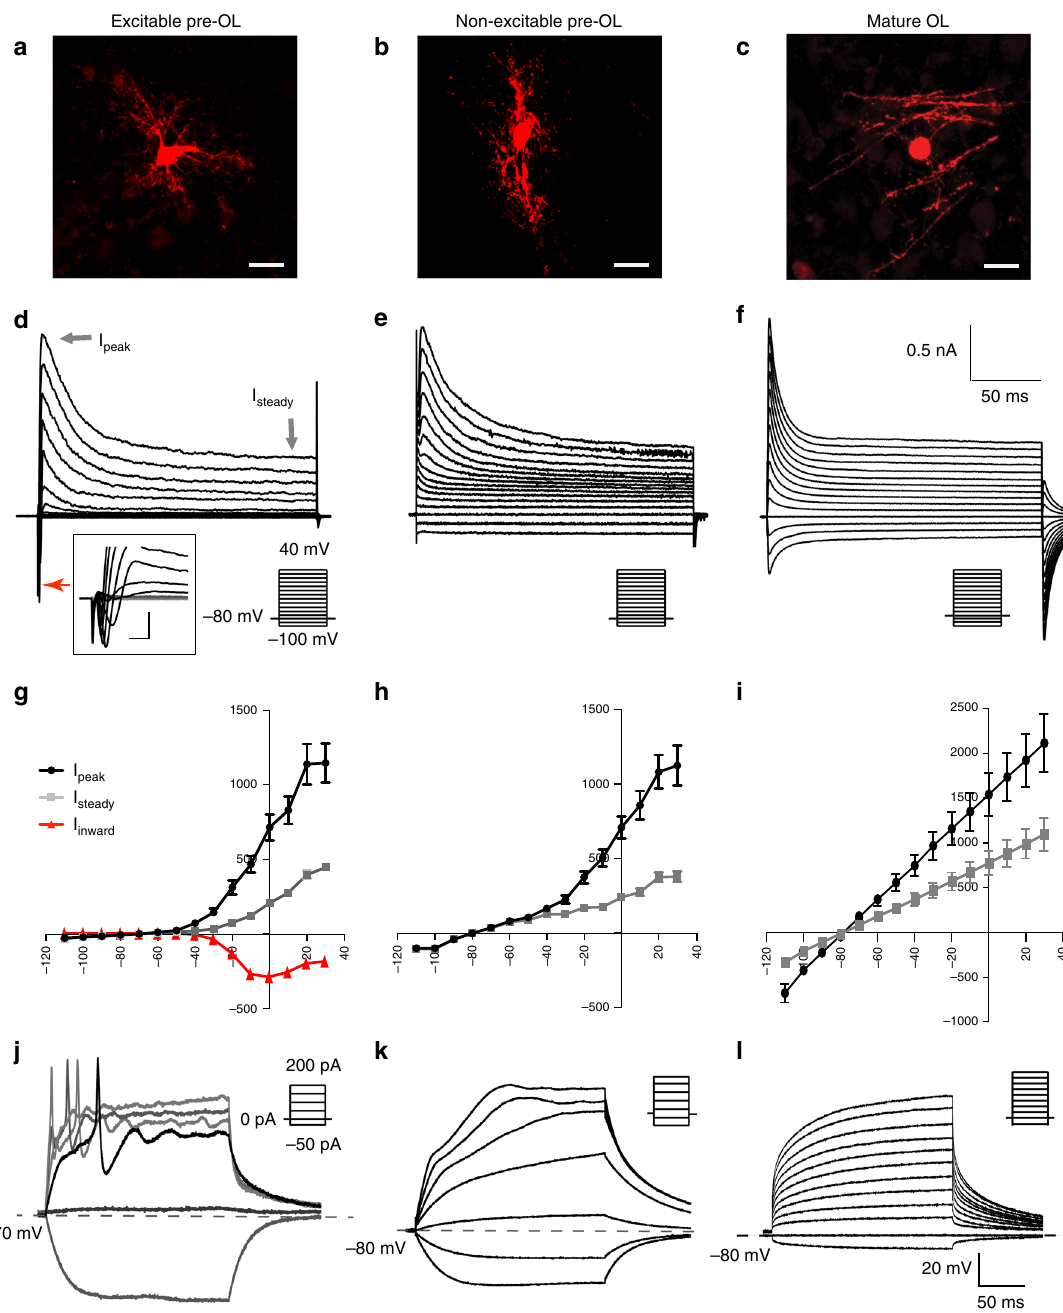
Fig. 3 Morphology and physiological properties of excitable vs. non-excitable pre-OLs and mature OLs. a – c Confocal images of excitable pre-OLs a , non-excitable pre-OLs b , and mature OLs c , which were fi lled with Alexa 568 during whole-cell recordings. Scale bar , 10 μ m. d – f Representative traces of Na v -mediated currents generated by voltage steps (from – 100 to 40 mV for d and e , from – 110 to 30 mV for f ) in excitable pre-OLs, non-excitable pre-OLs and mature OLs. Gray arrows indicate both peak outward currents (I peak ) and steady-state outward currents (I peak ), and the red arrow indicates inward currents. Inset , expanded time scale of inward currents from excitable pre-OLs (scale; 2 ms and 400 pA, d ). g – i Current – voltage ( I – V ) relationship for I peak ( black ), I steady ( gray ), and I inward ( red ) from excitable pre-OLs g . I-V relationship for I peak ( black ) and I steady ( gray ) from non-excitable pre-OLs h and mature OLs i . Data represent the mean ± s.e.m. j Excitable pre-OLs fi red APs in response to current injections ( > 50 pA, 300 ms) in current-clamp mode. k, l Recordings of membrane potential from a non-excitable pre-OL k and a mature OL l in response to current injections (300 ms, from – 80 to 200 pA for k , and – 50 to 400 pA for l ). Dashed lines indicate the resting membrane Astrocytes with GFAP+ processes did not show spiking proper- ties (Supplementary Fig. 1). The spike-generating excitable glia could thus be identi fi ed as OLs, not neurons or astrocytes. The resting membrane potential of excitable OLs was − 73 ±